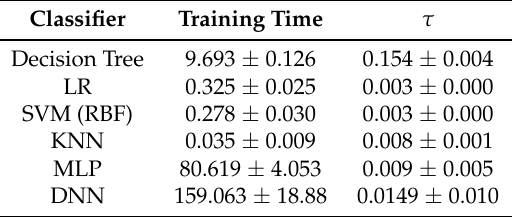
Table 9. Comparison of classifiers training time and average sample test time ( τ ) in